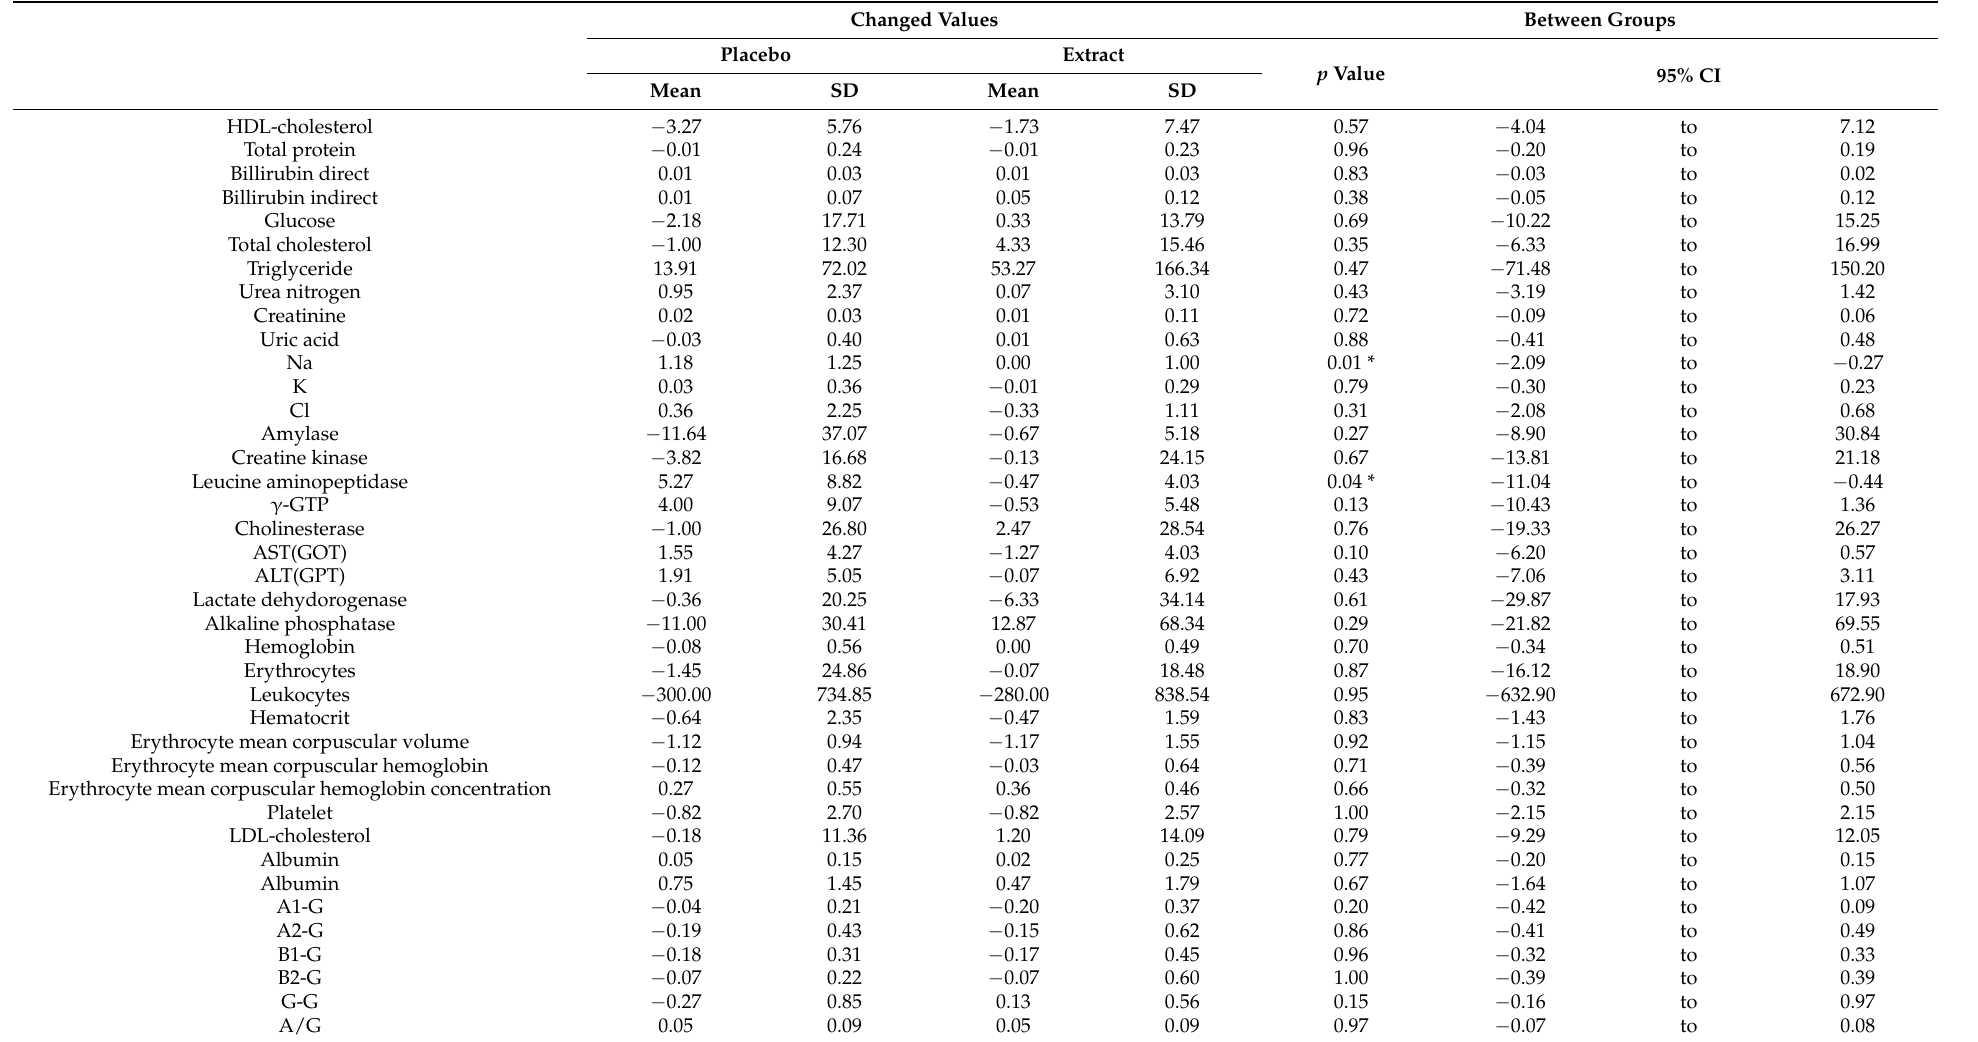
Table 7. Changes in evaluated blood parameters following the intake of CT extract and